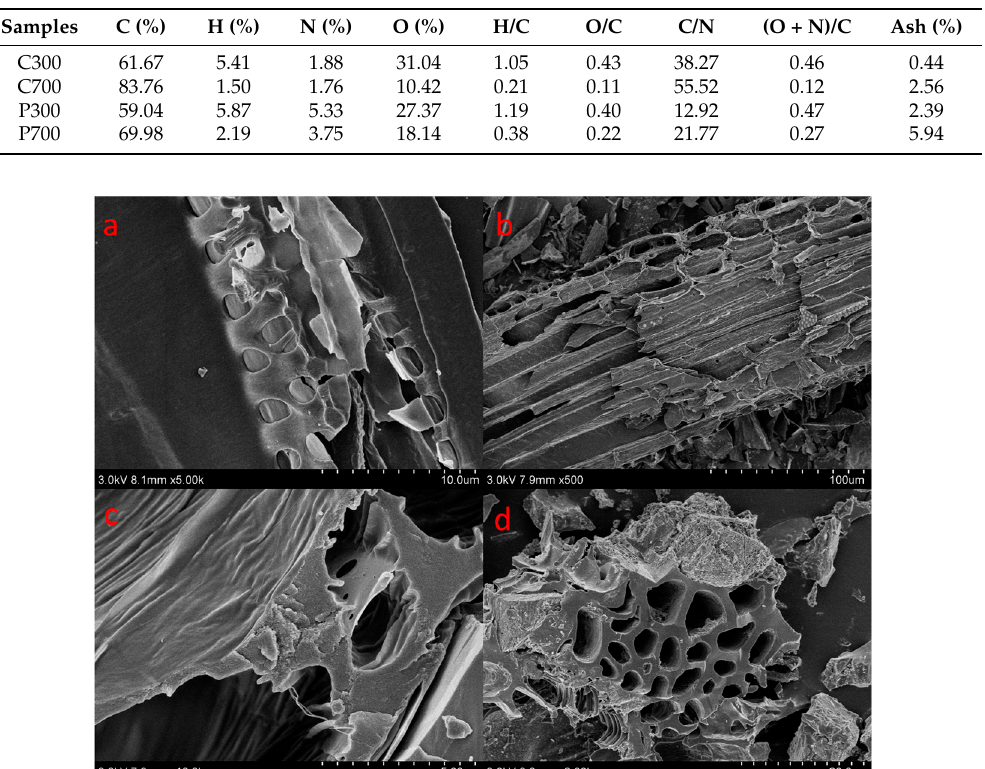
Figure 1. Scanning electron microscope images of C300 ( a ); C700 ( b ); P300 ( c ); and P700 ( d ).